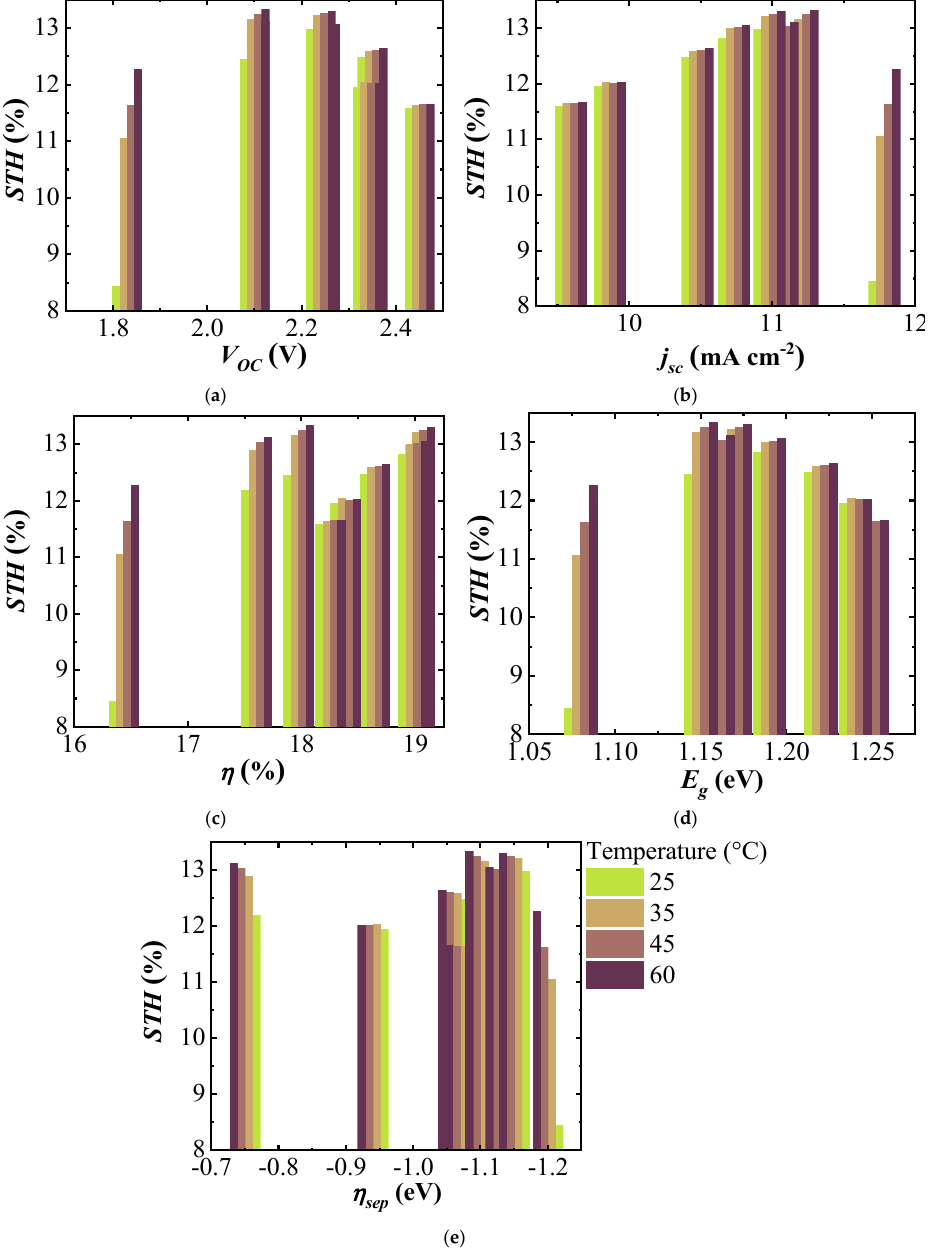
Figure 8. STH efficiency of the (A)CIGS–NiMo–NiO PV electrolyzer versus ( a ) 𝑉 (cid:3016)(cid:3004) , ( b ) 𝑗 (cid:3046)(cid:3030) , ( c ) 𝜂 , ( d ) Figure 8. STH e ffi ciency of the (A)CIGS–NiMo–NiO PV electrolyzer versus ( a ) V OC , ( b ) j sc , ( c ) η , ( d ) E g , 𝐸 (cid:3034) , and ( e ) 𝜂 (cid:3046)(cid:3032)(cid:3043) of the PV modules at different temperatures of the electrolyzer. and ( e ) η sep of the PV modules at di ff erent temperatures of the